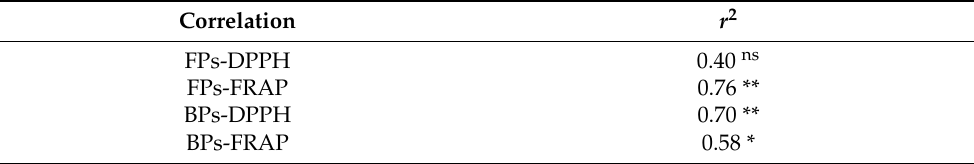
Table 4. Correlation between TPC and antioxidant capacity of mulberry